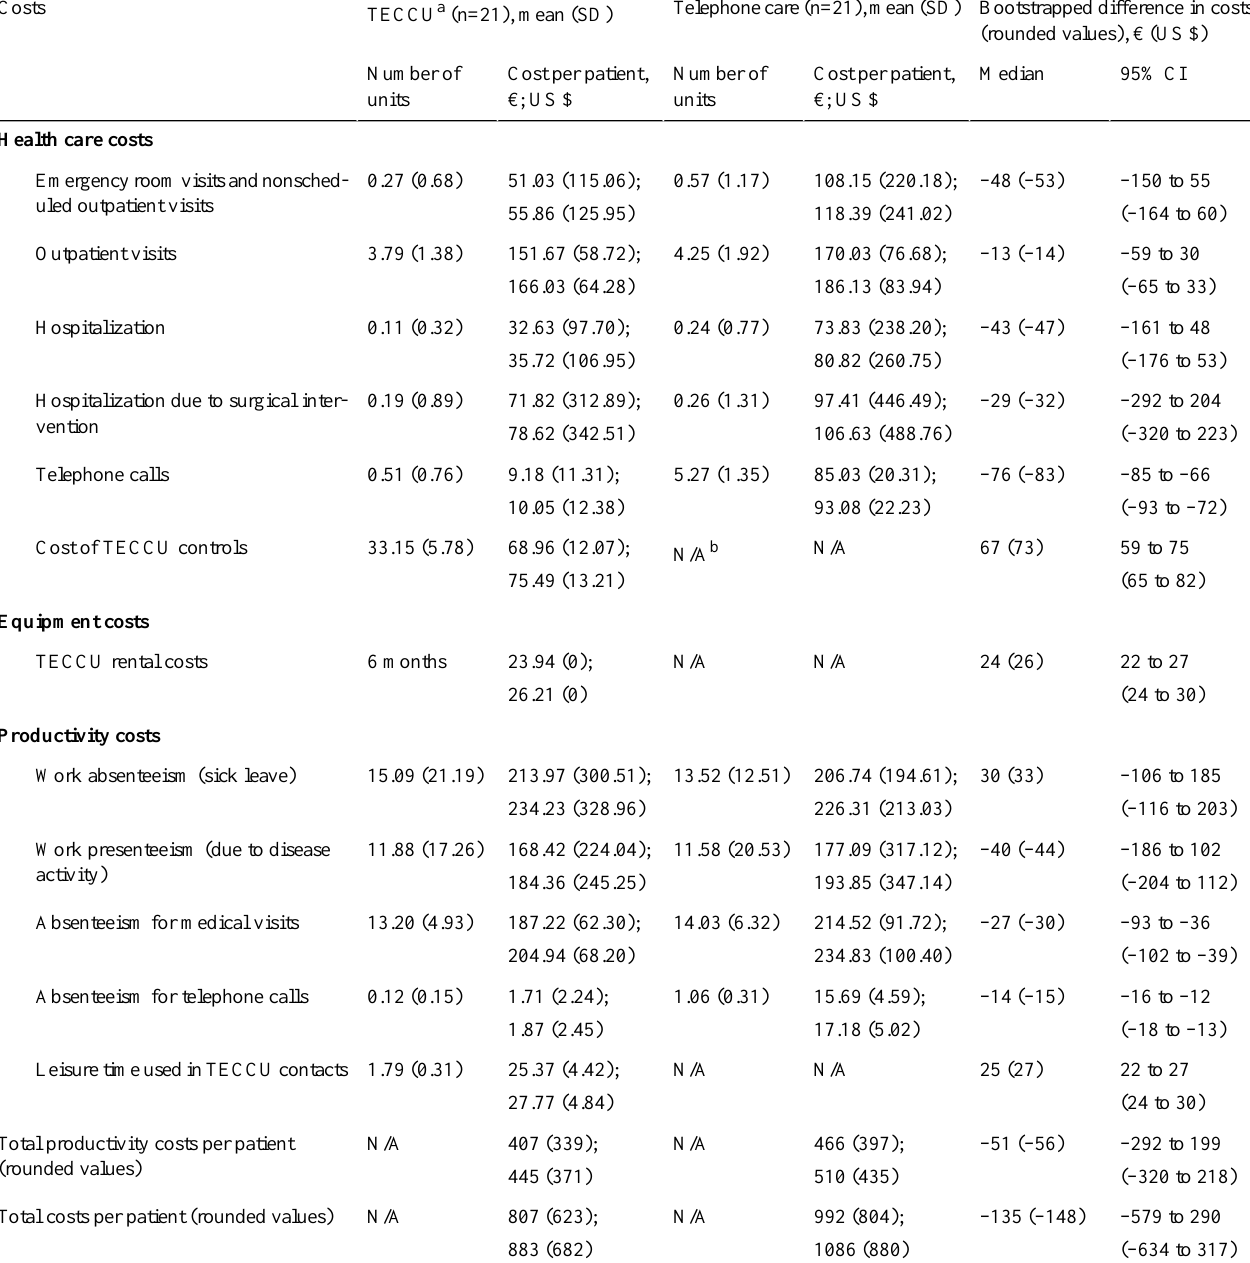
Bootstrapped difference in